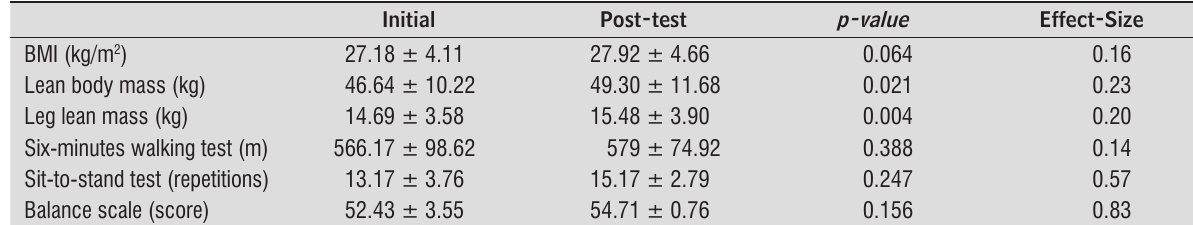
Table 3 - Secondary outcomes pre and